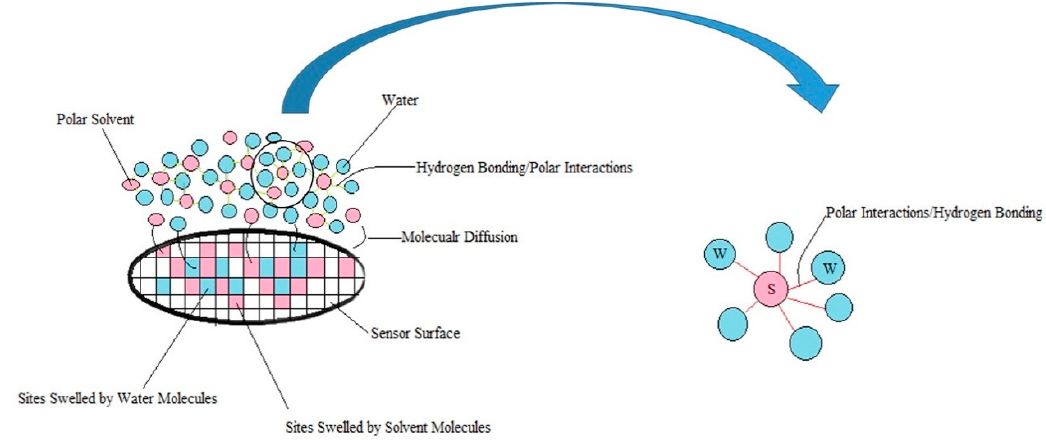
Figure 10. Assumed structure of water molecules around polar VOC molecules.